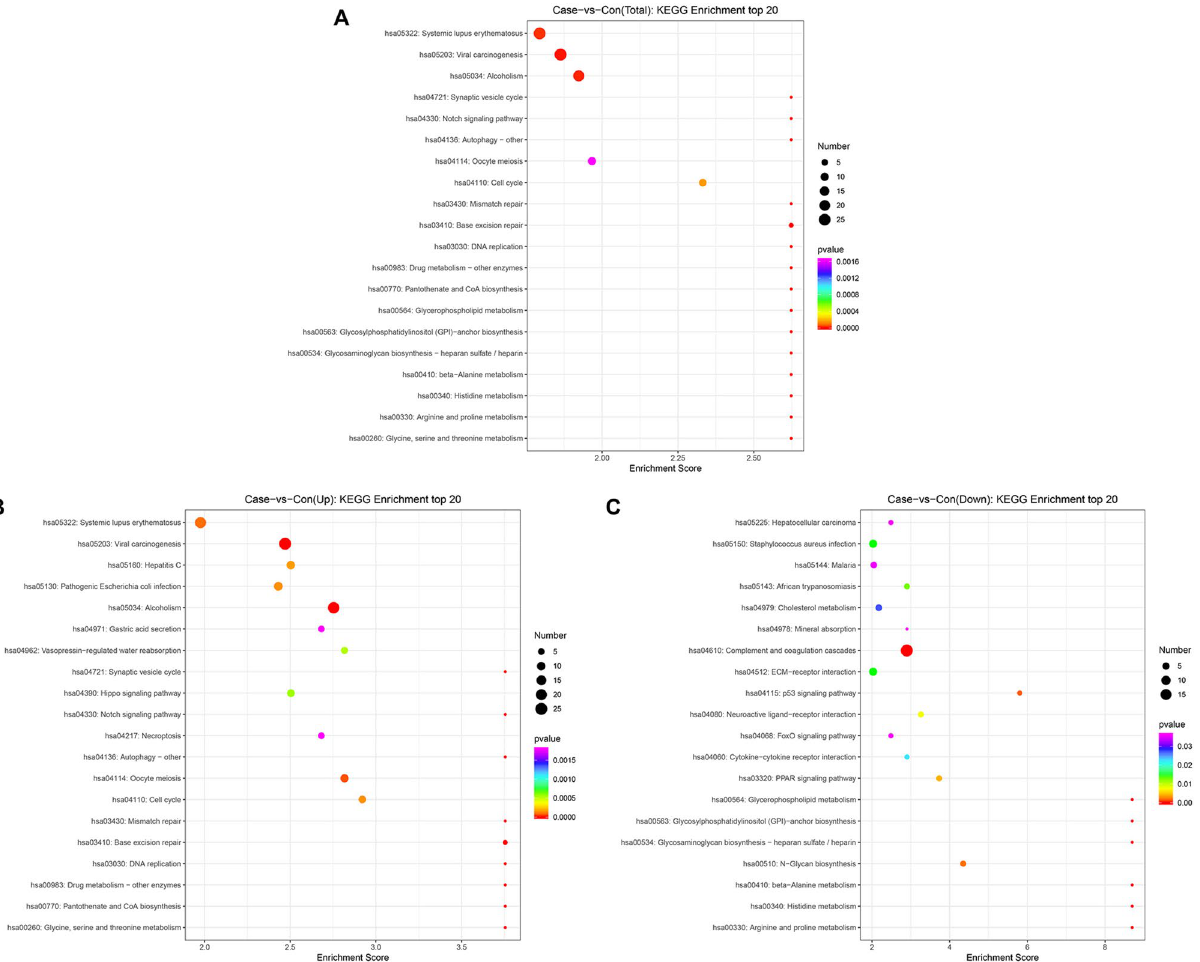
Figure 5. KEGG pathway enrichment analysis of the DEPs. Top 20 enriched pathways of ( A ) all DEPs, ( B ) upregulated DEPs, and ( C ) downregulated